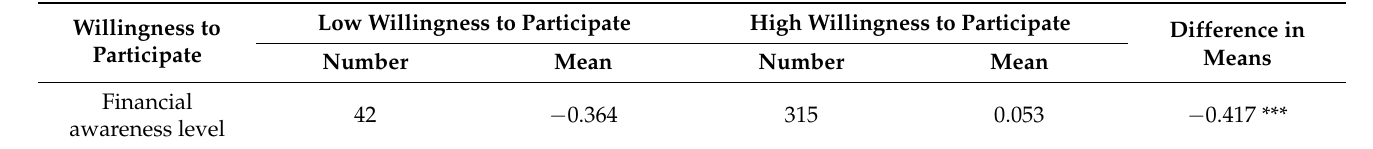
Table 3. Comparison of differences in residents’ financial perceptions affecting their willingness to participate in the development of the Giant Panda National Park.